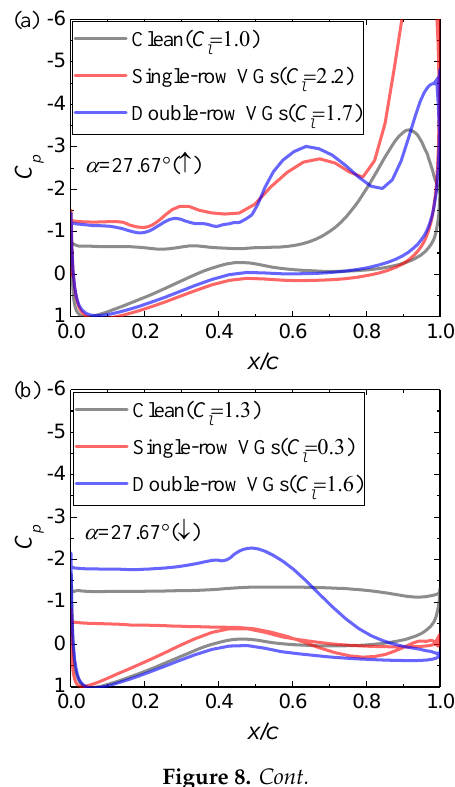
Figure 7. Streamlines and pressure fields around the airfoil with and without VGs.